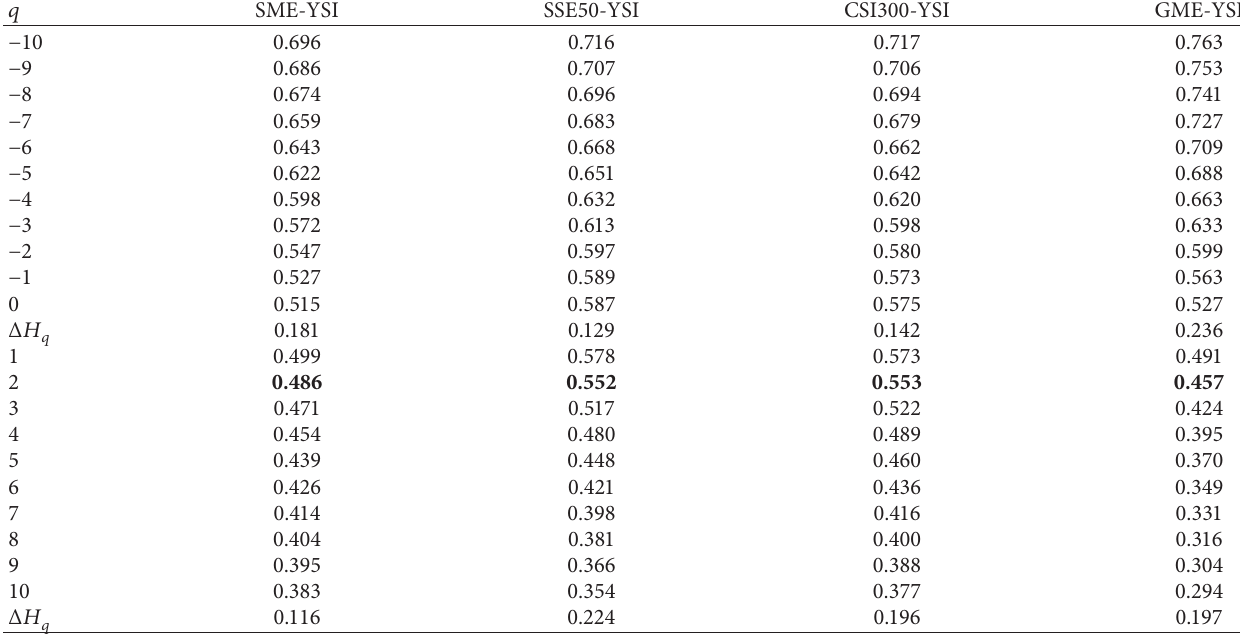
Table 4: Results of the MF-DCCA scaling exponent for Chinese stock market returns.